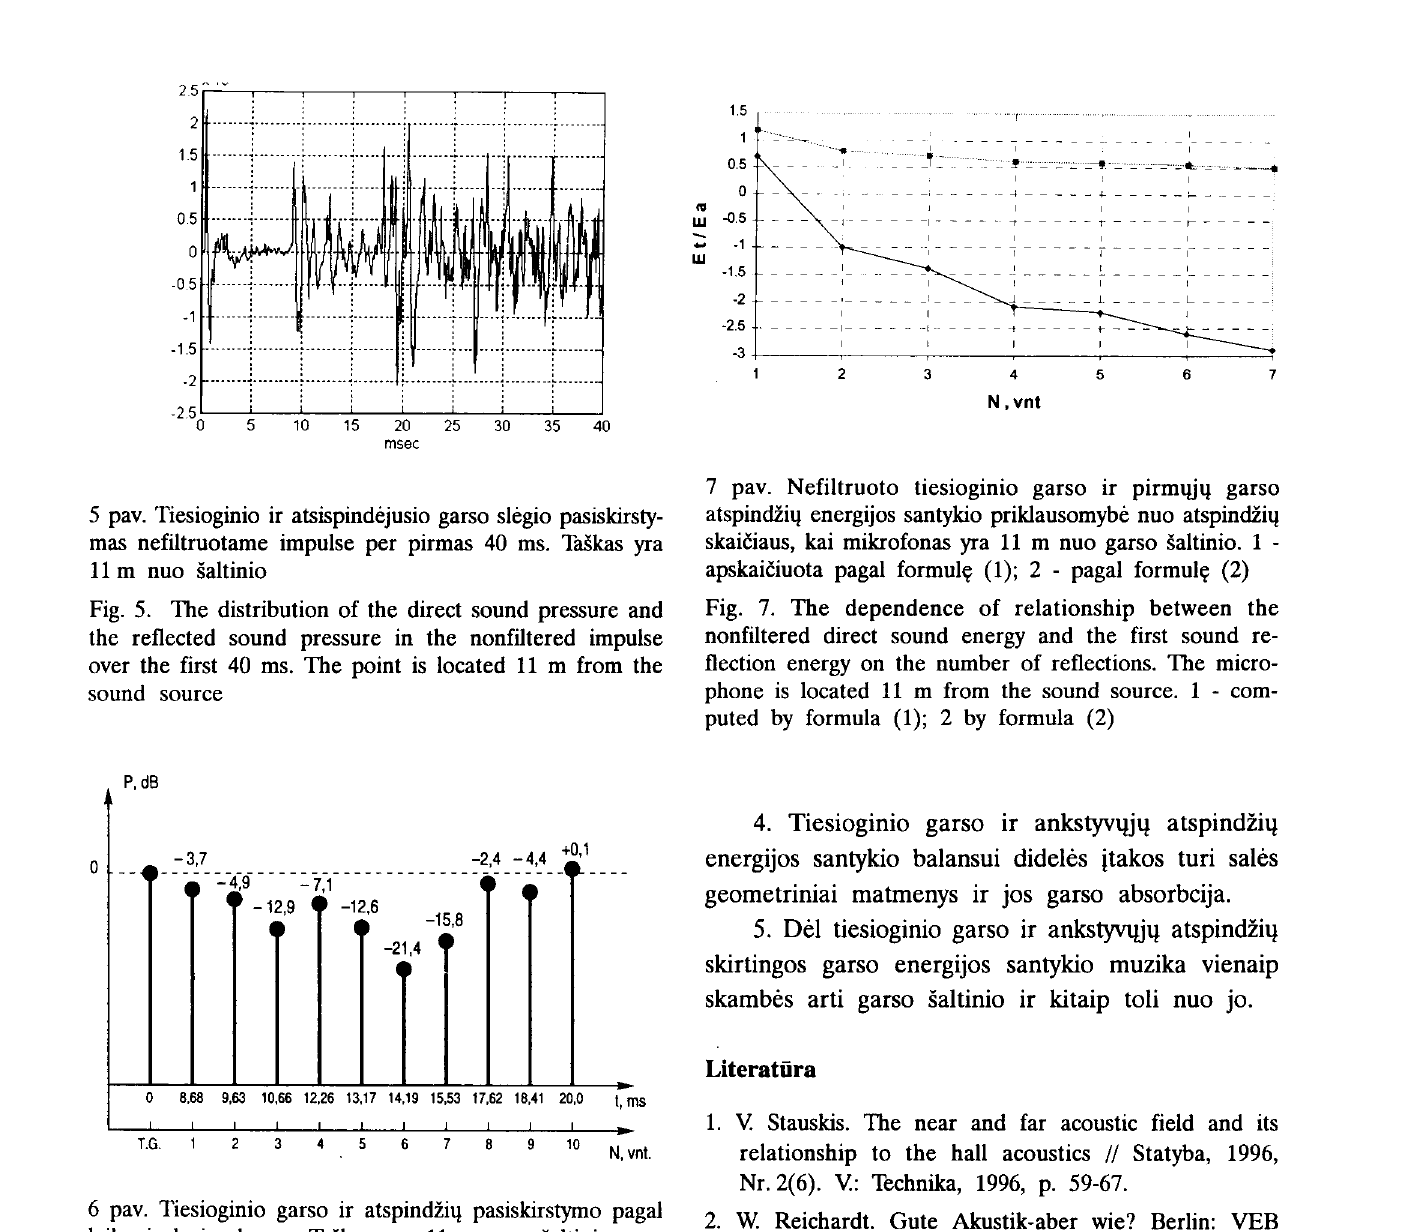
6 pav. Tiesioginio garso ir atspindziq pasiskirstymo pagal laik~ ir lygj schema. Ta8kas yra 11 m nuo saltinio Fig. 6. The diagram of the distribution of the direct sound and reflections by time and level. The microphone is located 11 m from the sound source